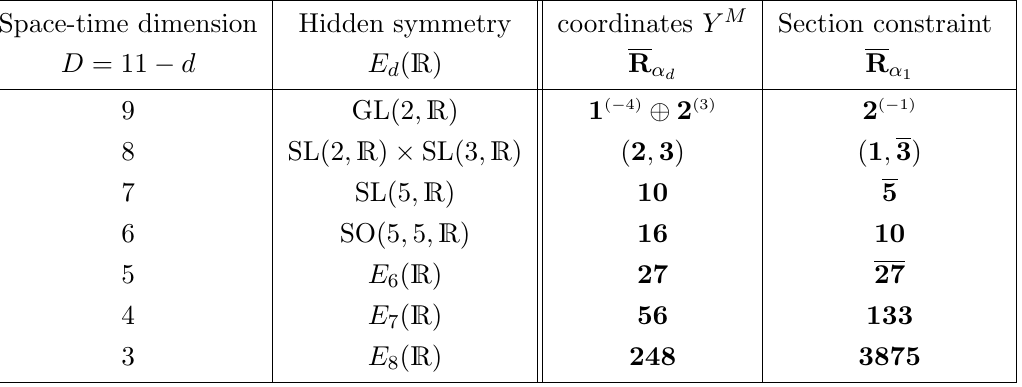
Coordinate representation R (cid:11) and strong section constraint representation R (cid:11) d hidden symmetry groups E in dimension D = 11 (cid:0) d for 2 (cid:20) d (cid:20) 8. d ( d ) symmetry group E ( R ) where d = 11 (cid:0) D . In order to eliminate extra degrees of d